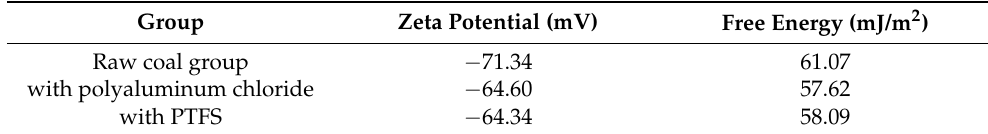
Table 4. Potential and free energy of